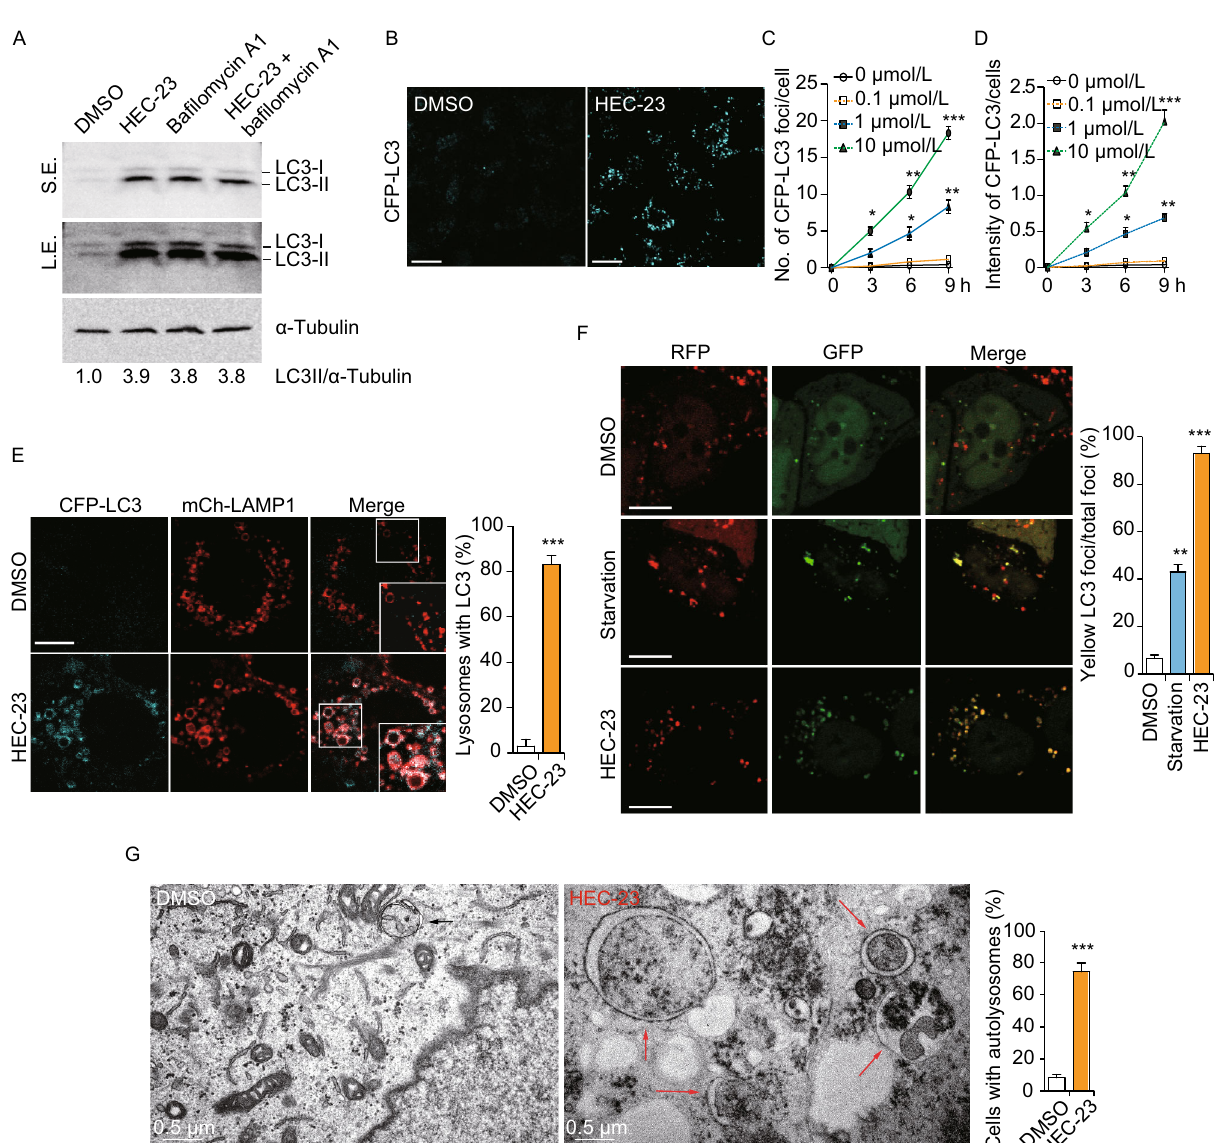
Figure 4. HEC-23 impairs autophagosome degradation. (A) Immuno-blotting of LC3 in HeLa cells treated with HEC-23 (10 μ mol/ L, 6 h) and ba fi lomycin A1 (0.4 μ mol/L, 6 h). Relative fold changes of LC3-II intensity are indicated at the bottom. (B – D) Representative images (B) and quanti fi cations (C and D) of CFP-LC3 foci in HeLa cells treated with HEC-23. (E) Representative images (left) and quanti fi cation (right) of the colocalization of stably expressed CFP-LC3 and mCh-LAMP1 in cells treated without or with HEC-23. Boxed regions in the merged images are magni fi ed and shown in the bottom right corners. (F) Representative images of RFP-GFP-LC3 foci in cells treated with DMSO, starvation (EBSS, 3 h), or HEC-23 (10 μ mol/L, 3 h). (G) Transmission electron microscopy images of cargo-containing autolysosomes in HeLa cells without or with HEC-23 treatment (10 μ mol/L, 6 h). For quanti fi cations, data (mean ± SEM) were from 3 independent experiments. * P < 0.05, ** P < 0.01, *** P < 0.001. Bars represent 10 μ m in all images except